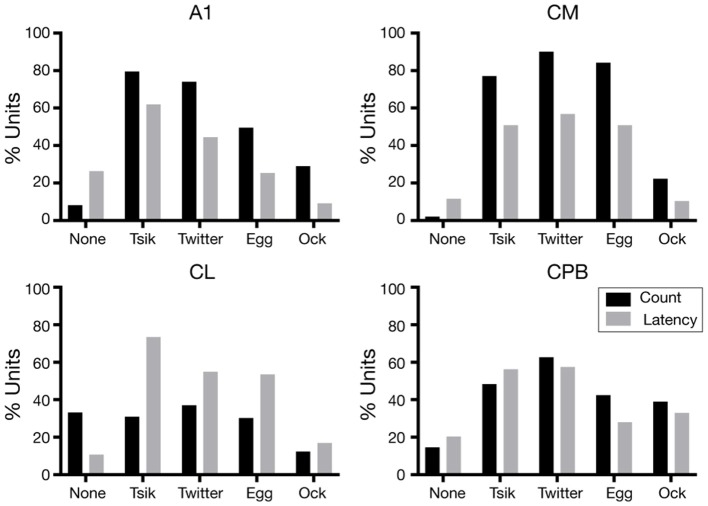
Proportions of pitch tuned units in the different neuronal populations, for the different calls. The proportions of units pitch tuned by spike-counts are shown in black and the proportions of units pitch tuned by first spike-latency variations are shown in gray.